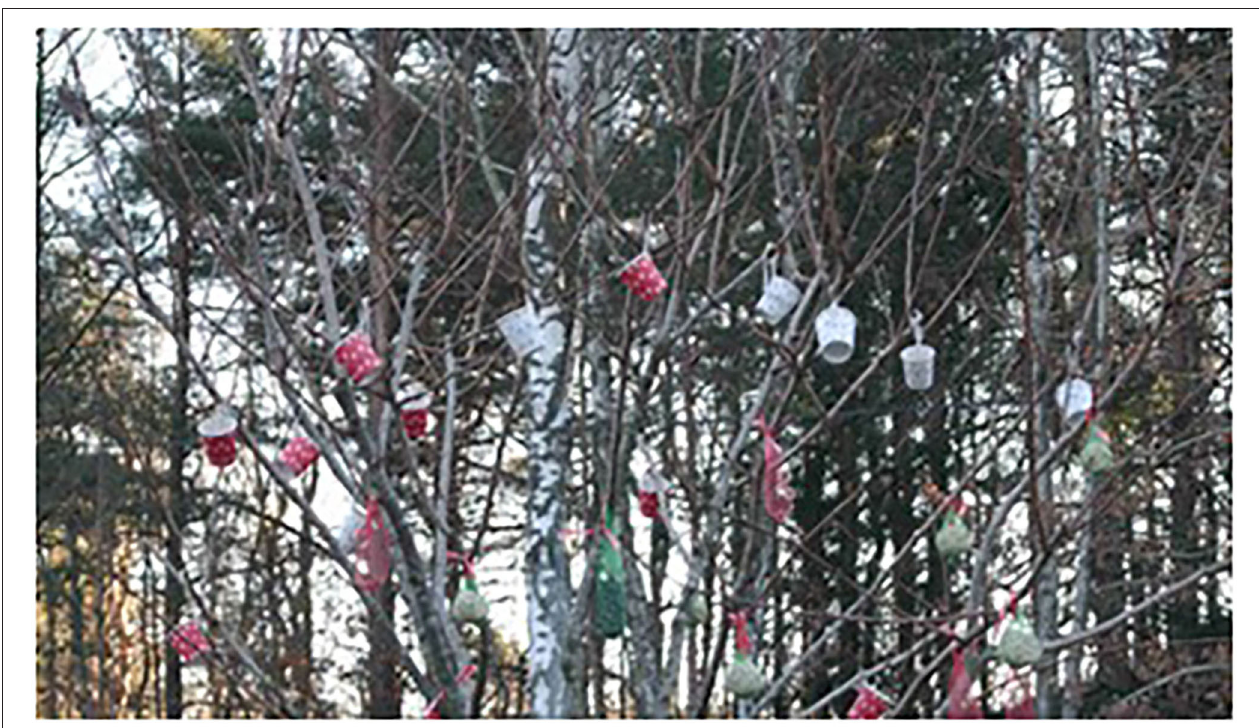
FIGURE 2 | Bird feeders in the